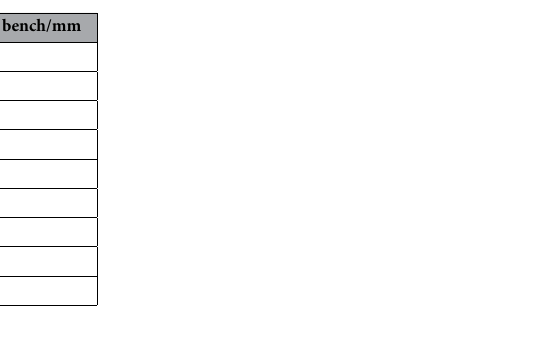
Table 2. Length comparison of wiring